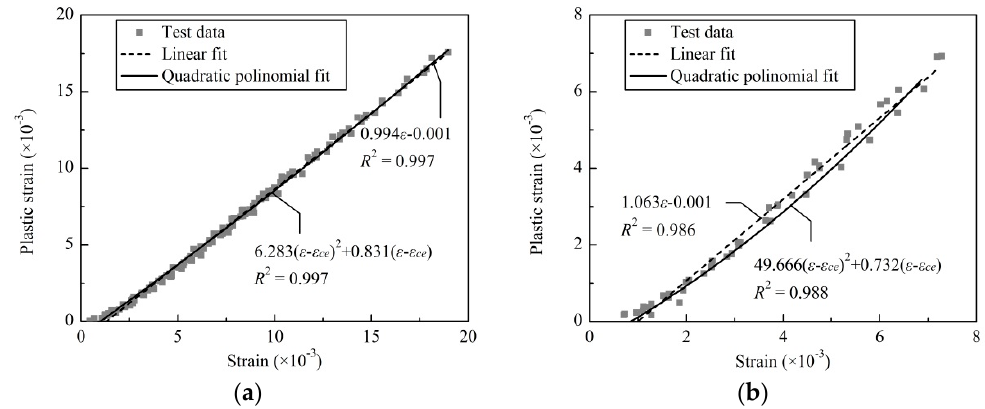
Figure 6. Proposed function for the ε p - ε relationship: ( a ) stirrup-confined concrete; and ( b ) unconfined concrete.